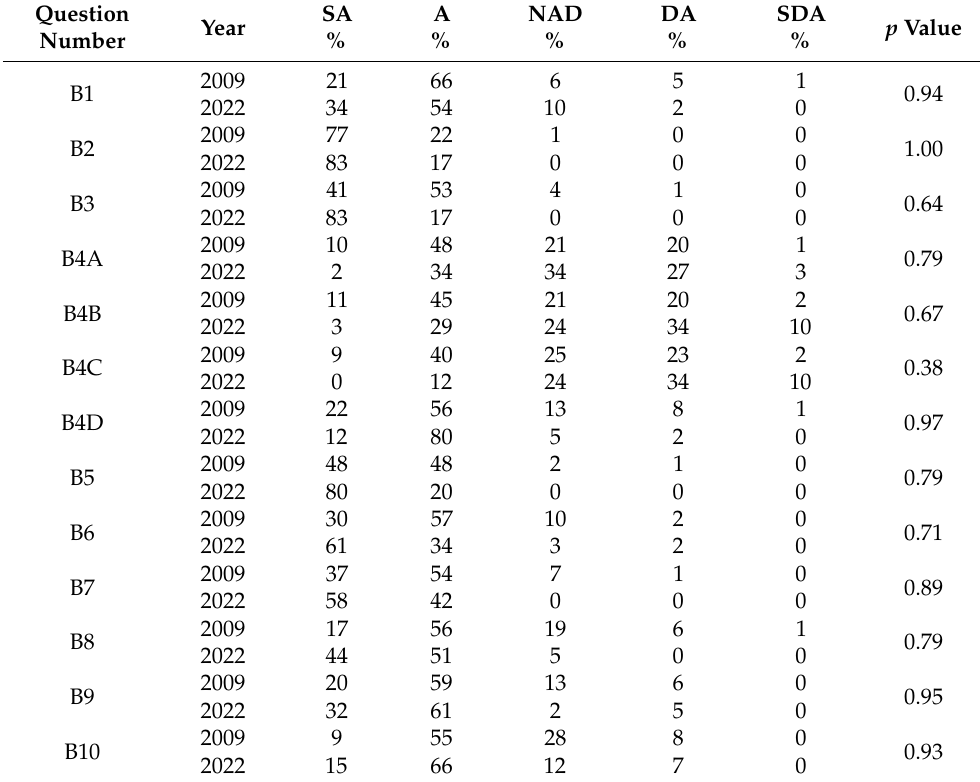
Table 5. Correlation between answers on self-perceived confidence in surgery from section B from the survey of final year students in 2009, n = 632 [20], and the Dundee University cohort of 2022, n = 41, using a Spearman’s correlation coefficient with a 95% confidence